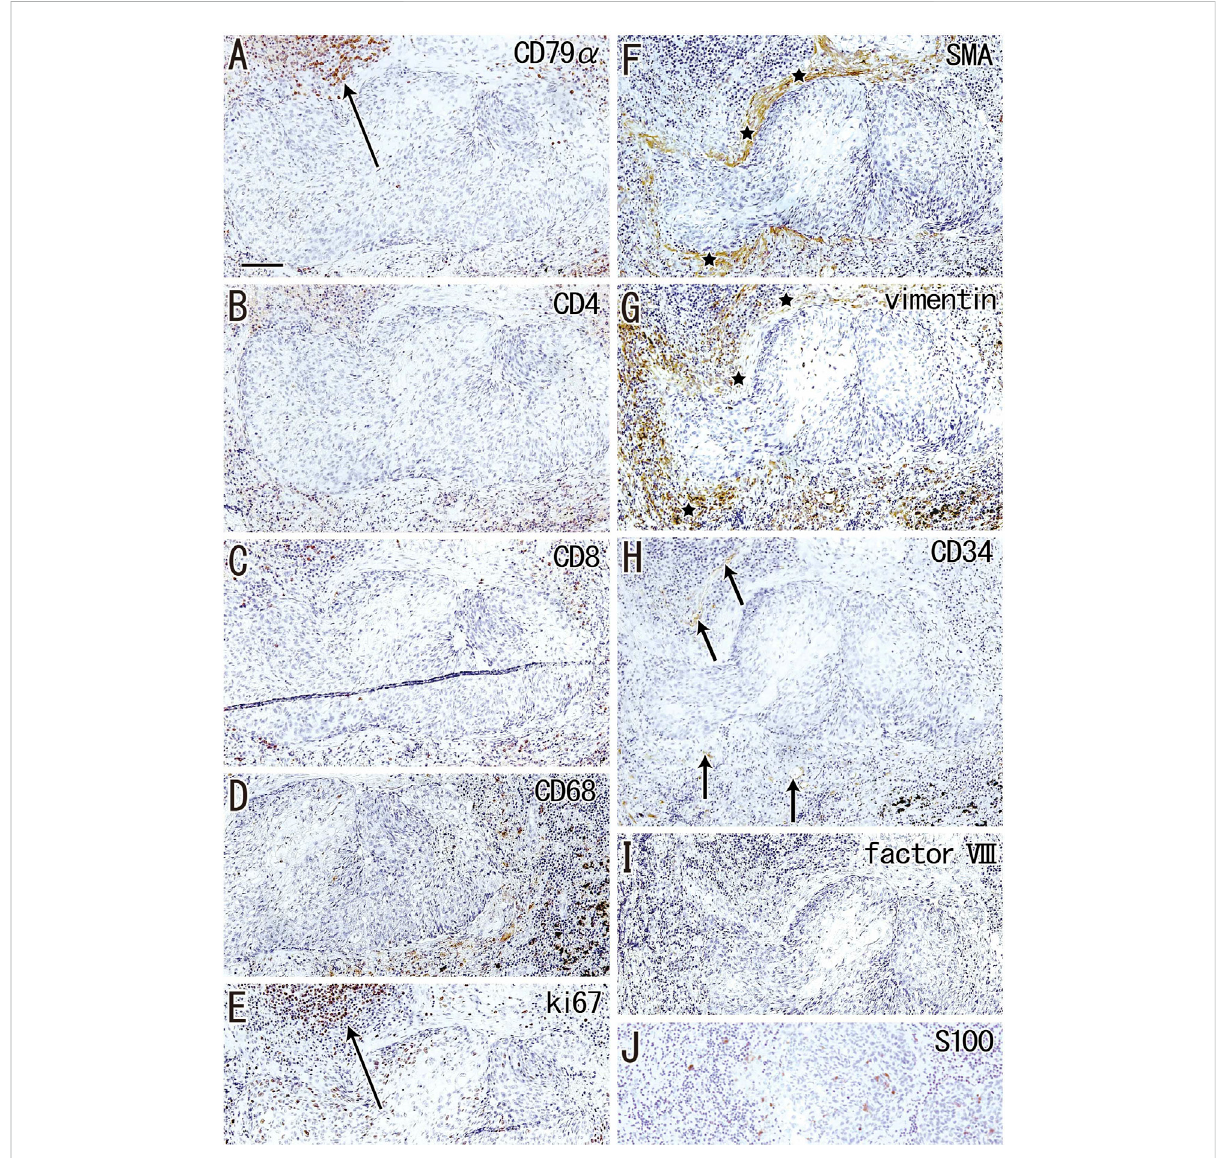
FIGURE 7 Immunohistochemistry of the cortical degeneration. Near sections of Figure 5A and higher magni fi cation views of a site indicated by a circle in Figure 5A (an interlobar node removed from a 78-years-old man). The DAB reaction made the positive cells brown. A follicle-like structure (degenerativecortex)occupiesinthecenterofeachpanel,butitcontainsnolymphocytesandmacrophagespositiveforCD79a (A) ,CD4 (B) ,CD8 (C) or CD68 (D) . Ki67-positive proliferating cells (arrow in (E) ) appear to be CD79a-positive B lymphocytes (arrow in (A) ). The degenerative area is surrounded by fi bers [stars in (F,G) ] positive for smooth muscle actin (SMA) or vimentin. Factor VIII-positive vessels are absent (I) , but CD34-positive vessels [arrows in (H) ] are present around the degenerative area. Langerhans ’ cell candidates (S100 protein-positive; (J) are seen in and around the follicle-like structure. All panels were prepared at the same magni fi cation [scale bar in (A) , 0.1